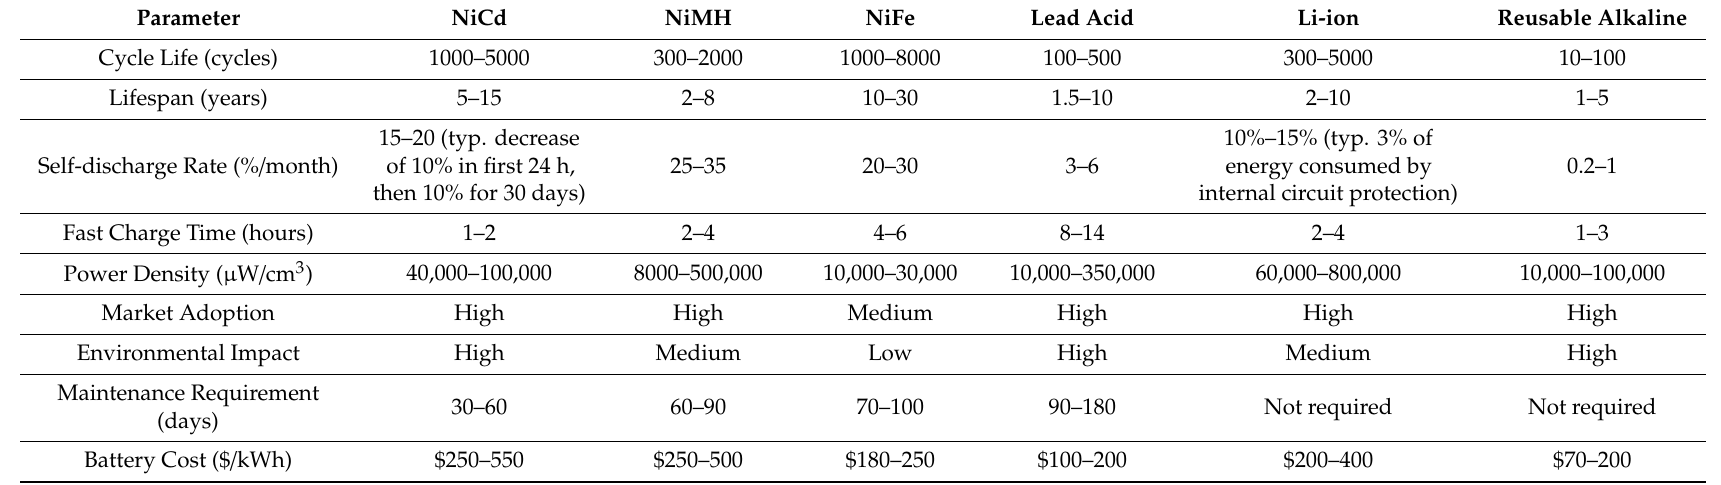
Table 4. Comparison of the key characteristics of various battery technologies used for sensing and monitoring in buildings. Data has been extracted or calculated from published literature, and various manufacturer datasheets and user manuals are available online at the time of